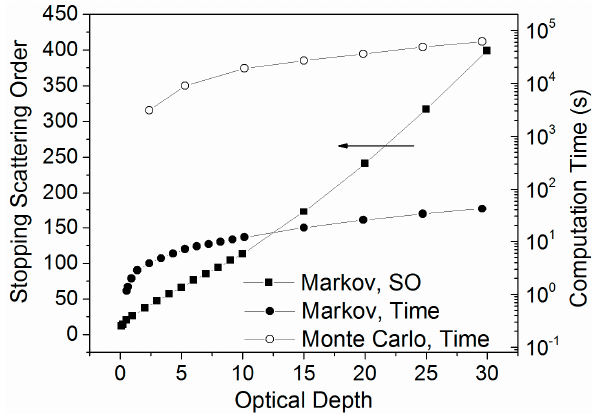
Figure 12. Modified Markov chain inversion computational cost and stopping scattering order as a function of the OD, in comparison to Monte Carlo simulations.